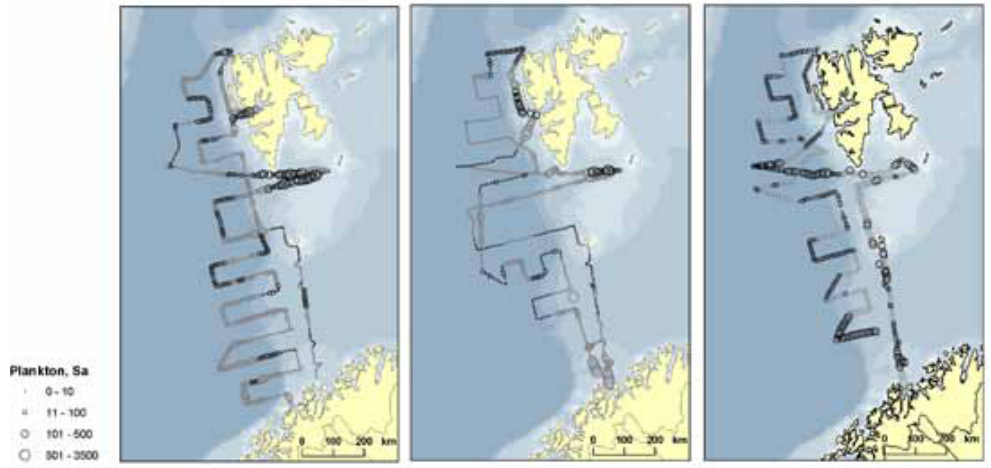
Fig. 3. Distribution of plankton along the cruise lines in 2000, 2001 and 2002. Black cruise line segments indicate segments with observer effort >0 which are included in the statistical analyses of cetacean habitat and prey selection, grey cruise line segments indicate segments with observer effort=0 which are not included in the statistical analyses.